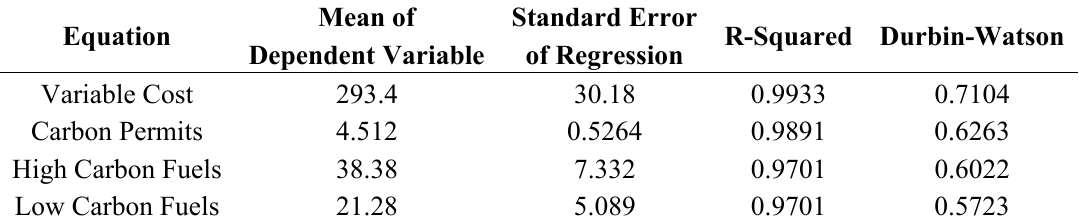
Table 4. Summary fit